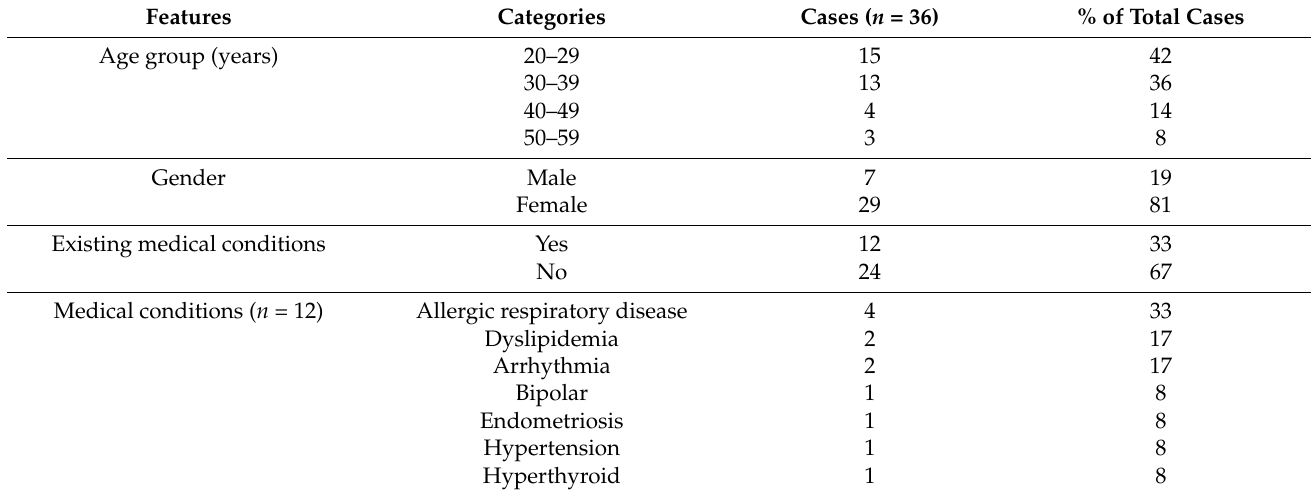
Table 2. Demographic data and clinical features for